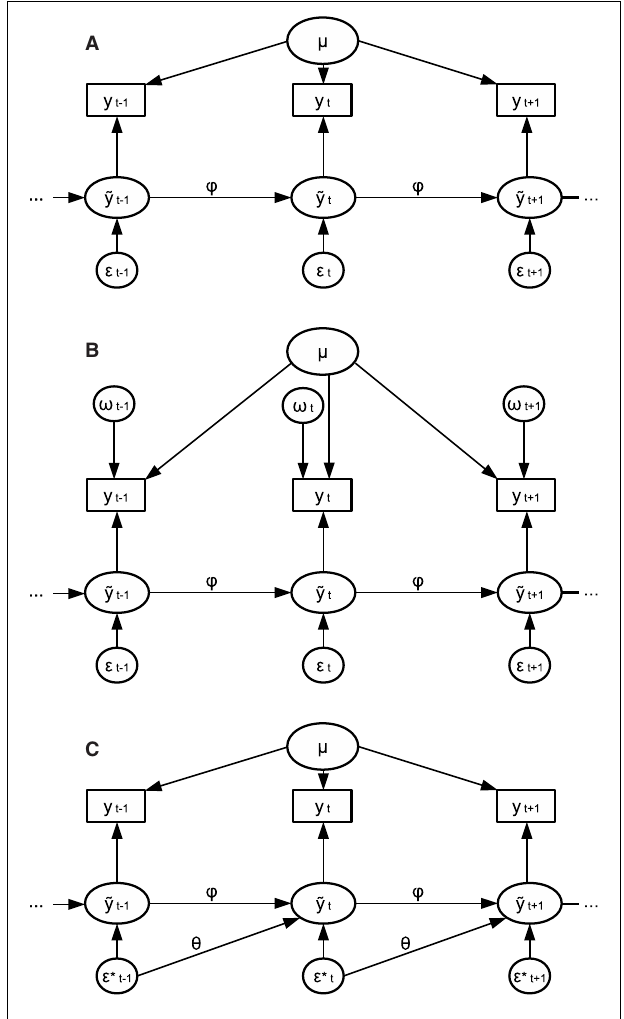
FIGURE 1 | (A) Graphical representation of an AR(1) model. (B) Graphical representation of an AR(1) + WN model. (C) Graphical representation of an ARMA(1,1) model.